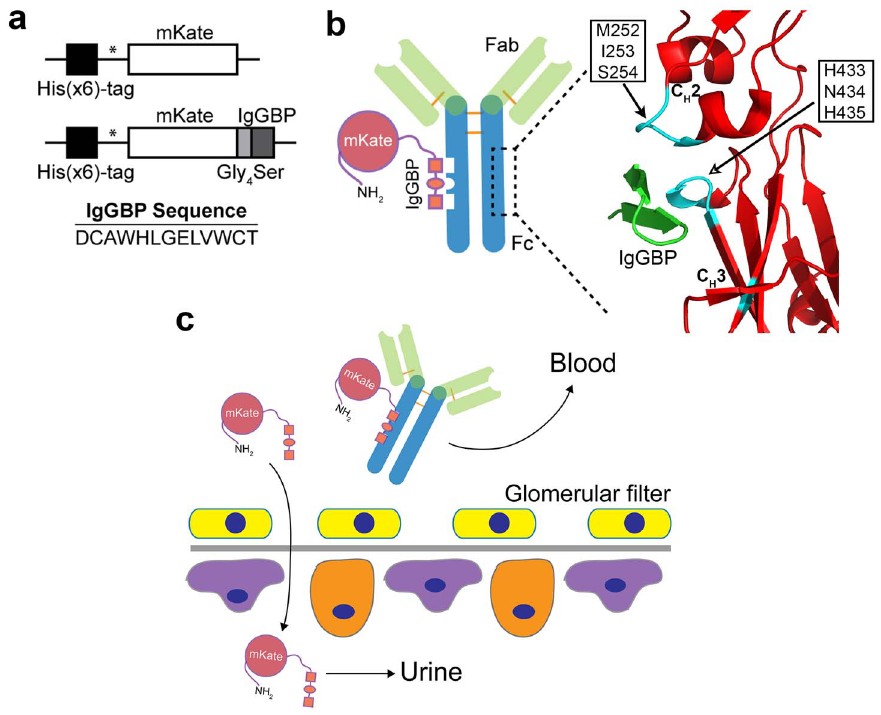
Figure 1. IgGBP fusion as a strategy to improve protein half-life by targeting serum IgG. ( a ) Schematic of genes encoding mKate or mKate modified at its C-terminus with an IgGBP sequence. * indicates thrombin cleavage site for removal of poly-histidine tag. ( b ) Cartoon depicting binding of mKate-IgGBP to the Fc-domain of hIgG and the corresponding crystal structure [16] of the IgGBP (green) in complex with Fc (red) (PDB 1DN2). Critical Fc amino acids that contribute to IgGBP binding at the C H 2–C H 3 interface are colored cyan. The same set of Fc residues is critical for FcRn binding. ( c ) Proposed half-life extension mechanism of IgGBP fusion. mKate-IgGBP binds serum IgG thus restricting its excretion through the kidney whereas unbound mKate-IgGBP is cleared through the glomerulus.